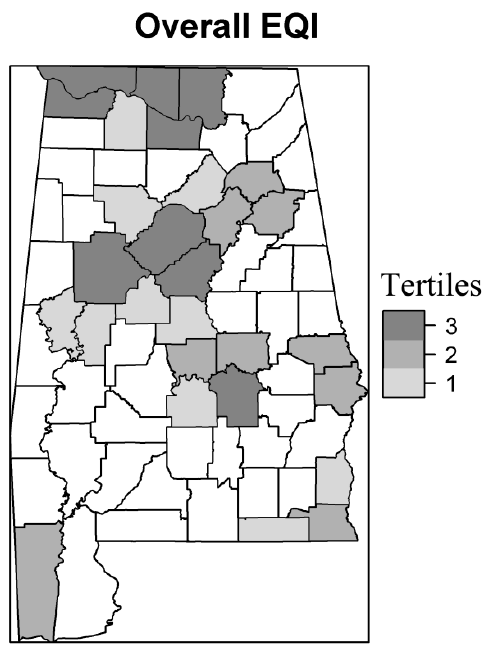
Figure 1. Tertiles for overall Environmental Quality Index (EQI) in metropolitan counties in Alabama. Non-metropolitan counties are white. Tertile 1: counties with the best overall environmental quality in metropolitan areas; tertile 2: counties with median level overall quality; tertile 3: counties with the worst overall environmental quality.